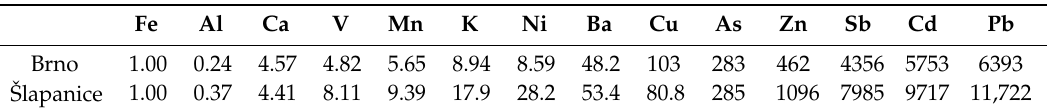
Table 5. Enrichment factors calculated from the element concentrations determined in PM 1 aerosols collected in Brno and